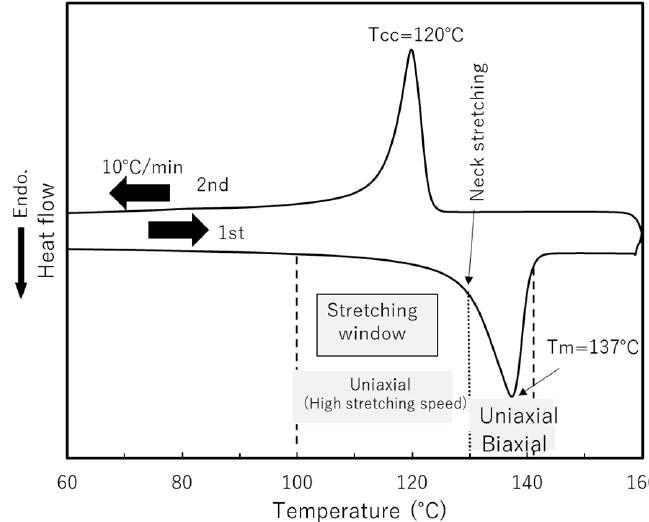
Figure 1. DSC measurement results for sample film showing stretching window in the experiment.